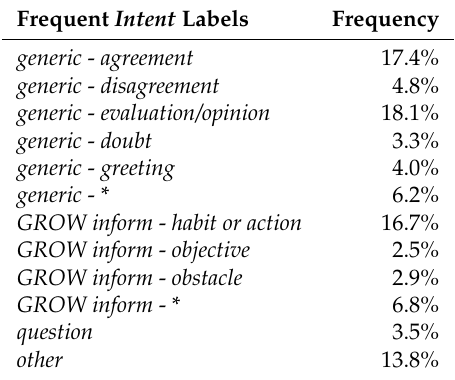
Table 4. Frequencies of the most frequent intent labels. The sets marked with the symbol * include all the labels under a given label, and also the cases where the annotator has not selected any